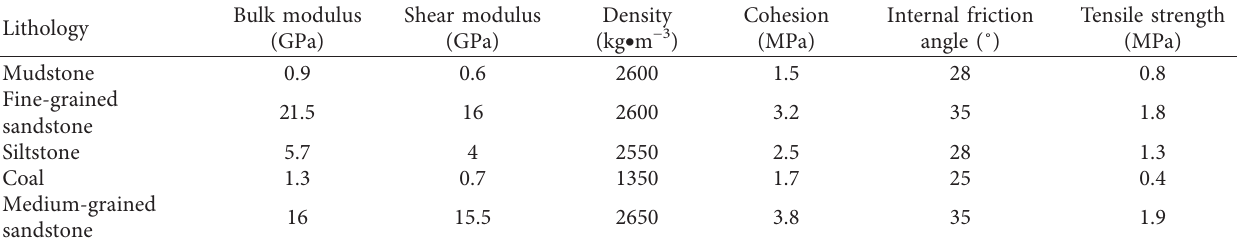
Table 1: Rock mass